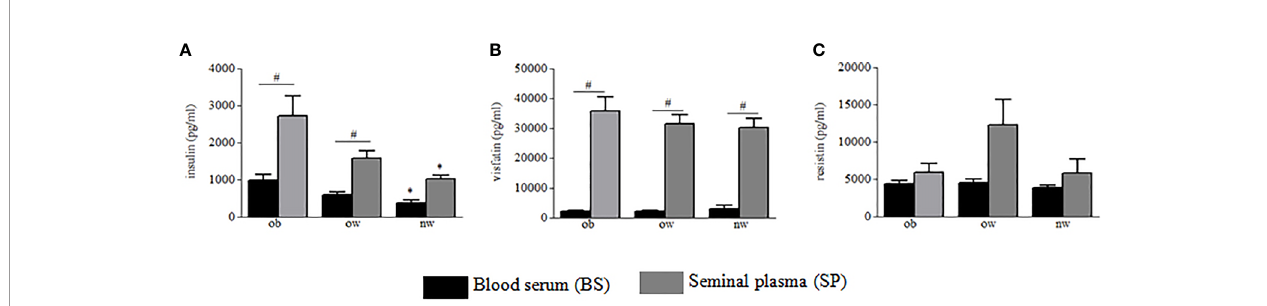
FIGURE 2 | Blood serum (black columns) and seminal plasma (gray columns) of obese, over- and normal weight subjects were analyzed for insulin (A) , visfatin (B) , and resistin (C) . Data are presented as the means ± SE. Statistical signi fi cance was determined using ANOVA with Bonferroni ’ s post-hoc test. * P < 0.05 vs . obese subjects; # P < 0.05 vs . corresponding adipokine levels between blood serum and seminal plasma. ob, obese; ow, over-weight; nw, normal weight.